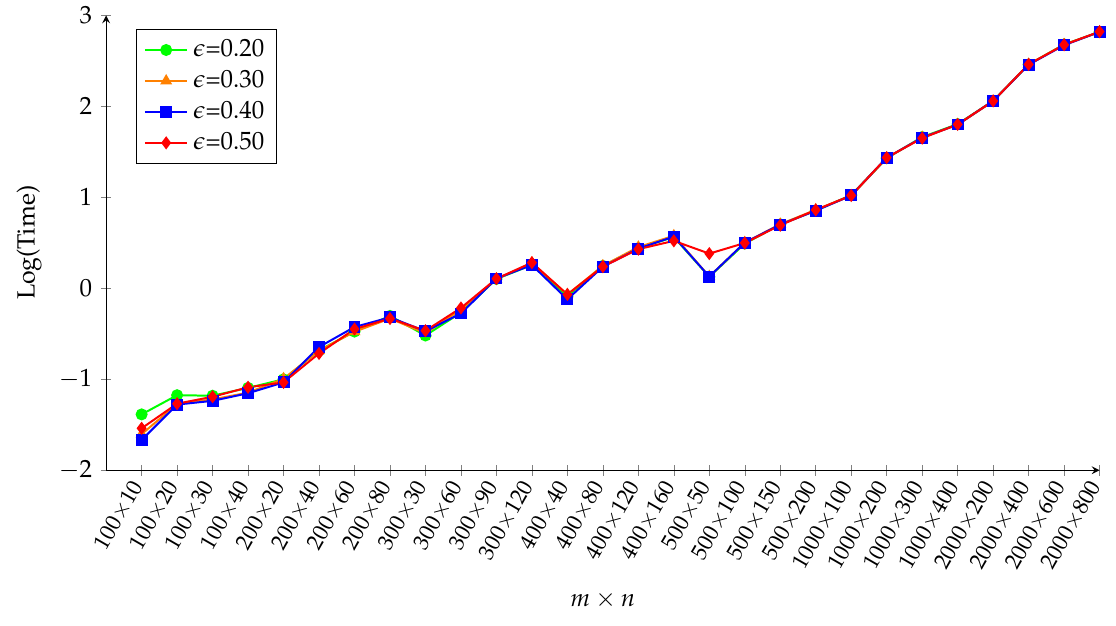
Figure 5. SAJS performances by varying the stopping